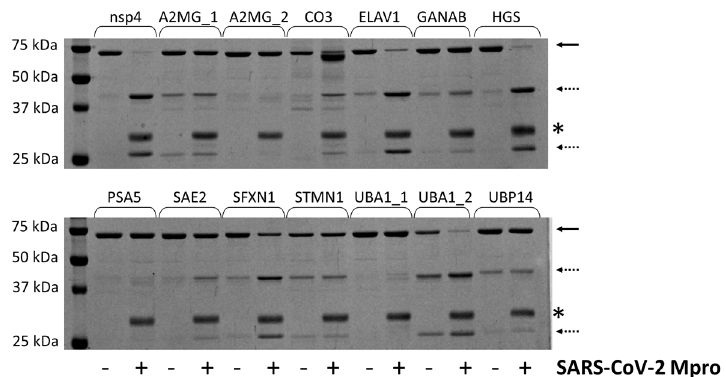
Figure 3. Cleavage of recombinant substrates by SARS-CoV-2 Mpro. The representative gel image shows SDS-PAGE analysis of the recombinant His 6 -MBP-mEYFP substrates after incubation with or without SARS-CoV-2 Mpro. The continuous and dashed arrows indicate the full-length substrates and the cleavage products, respectively. An asterisk indicates the band of the enzyme. The nsp4 indicates the substrate representing the TSAVLQ*SGFRKM autoproteolytic cleavage site of SARS- CoV-2 polyprotein [12].